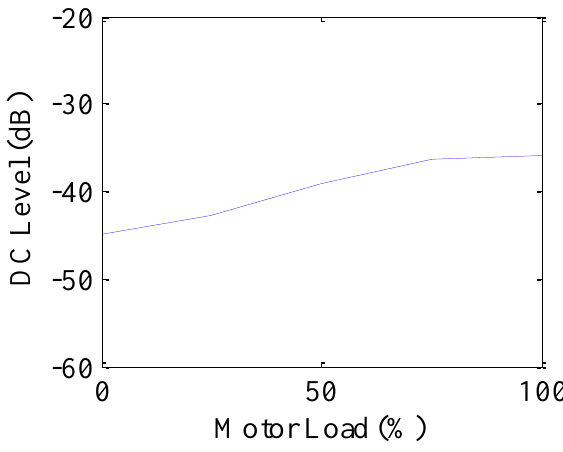
Figure 2. DC bias disparities with respect to motor operating point.